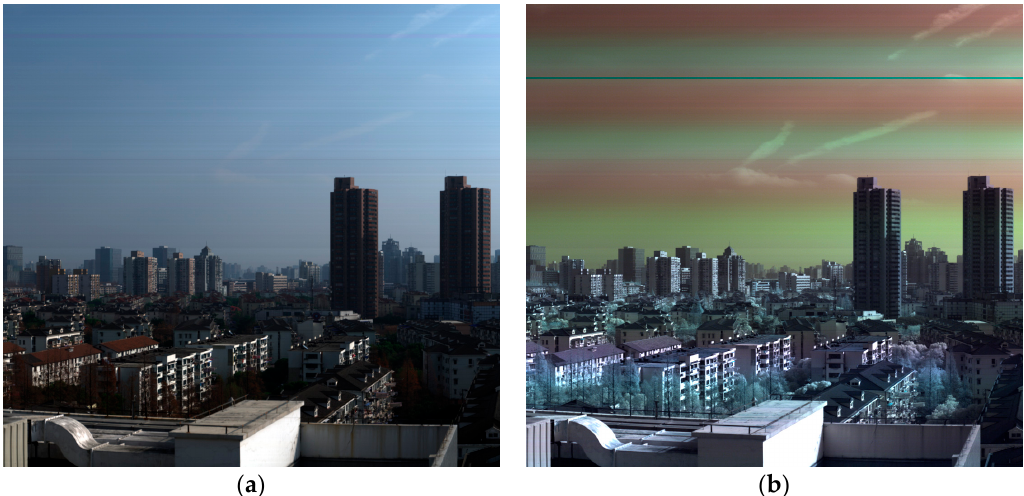
Figure 7. Image data collected from Camera 2. ( a ) RGB image in visible bands (R: 650 nm, G: 560 nm, B: 480 nm); ( b ) False-color RGB image in NIR bands (R: 800 nm, G: 890 nm, B: 960 nm).